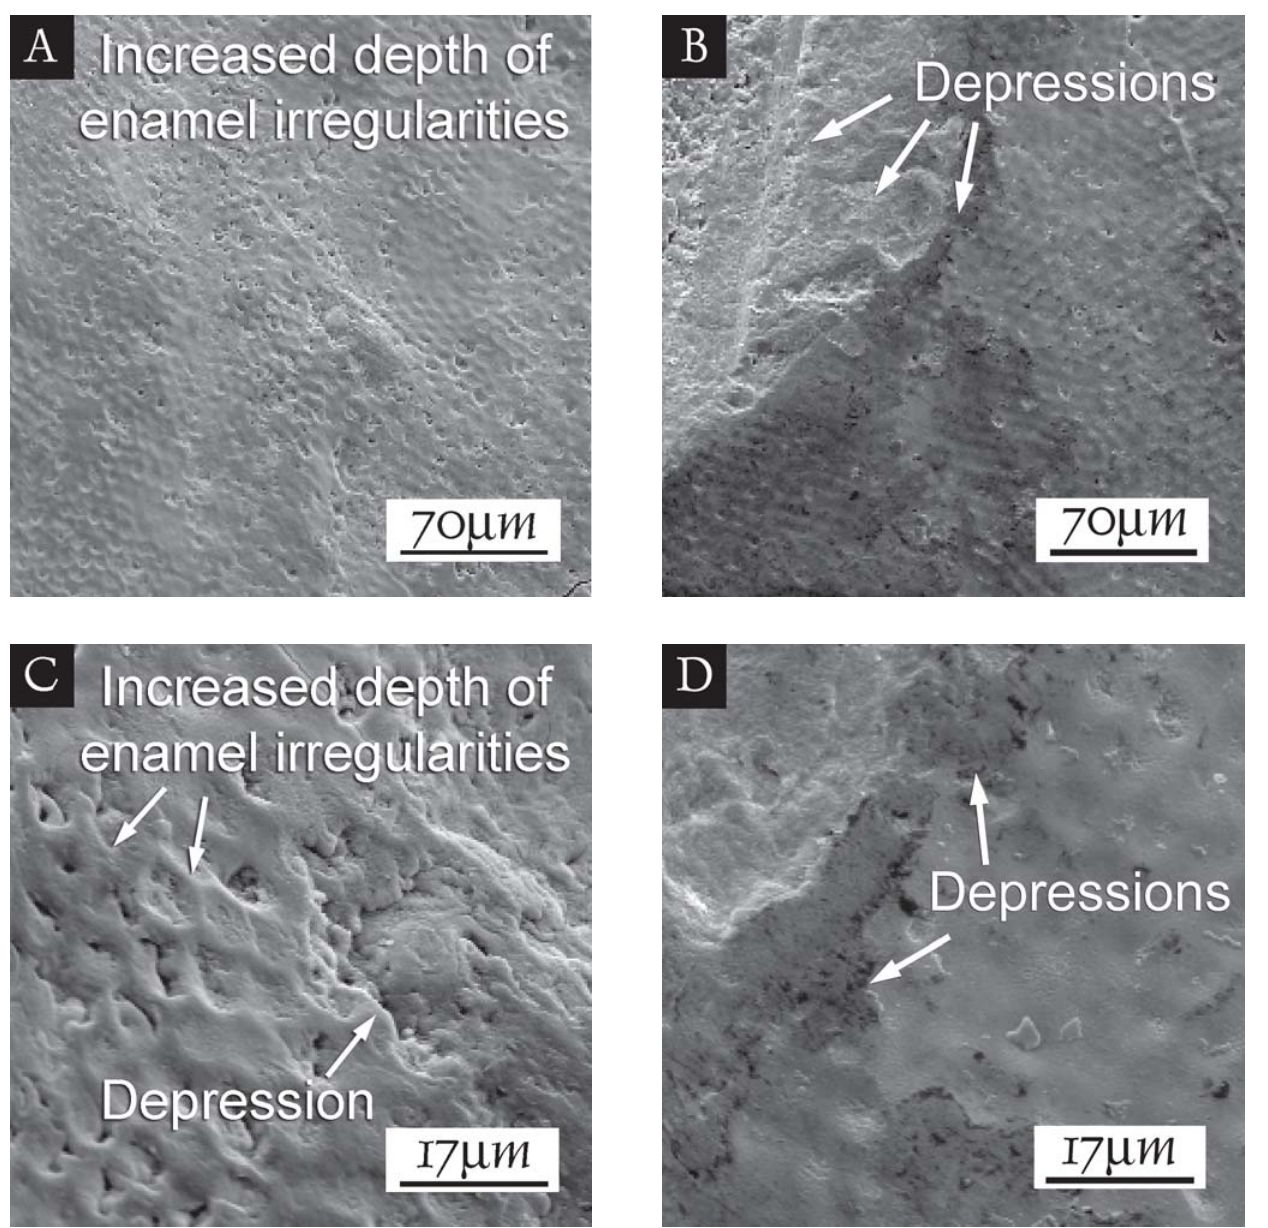
FIGURE 3- Photomicrographs of bleached enamel after 35% carbamide peroxide applications at 500x (A and B) and 2000x magnifications (C and D): depressions and increased depth of enamel